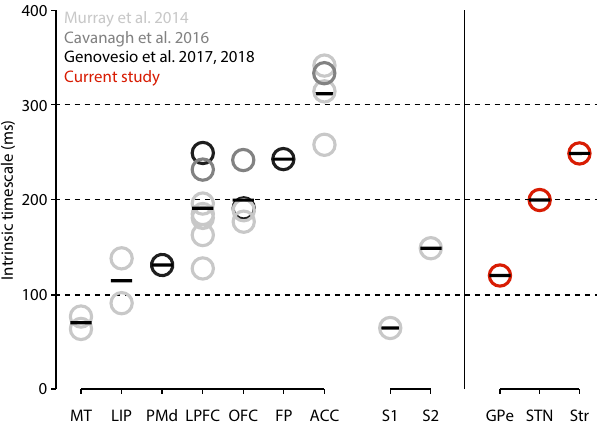
Figure 2. Hierarchical organization of intrinsic timescales of cortical and subcortical structures. Left Panel: Intrinsic timescales of nine cortical areas reported by 4 in light gray, by 20 in medium gray, and by 6,21 in dark gray. The seven areas on the left (MT, LIP, PMd, LPFC, OFC, FP, and ACC) are part of the visual and prefrontal cortices. The two areas on the right are part of the somatosensory cortex (S1, S2). Each circle represents the average τ for each cortical area reported in each study. Each bar represents the average τ among the studies. Right Panel: Same representation for the three subcortical structures (GPe, STN, and striatum) analyzed in the present study. ACC, anterior cingulate cortex; FP, frontopolar cortex; GPe, external globus pallidus; LIP, lateral intraparietal cortex; LPFC, lateral prefrontal cortex; MT, medio-temporal area (of visual cortex); OFC, orbitofrontal cortex; PMd, dorsal premotor cortex; S1, primary somatosensory cortex; S2, secondary somatosensory cortex; STN, subthalamic